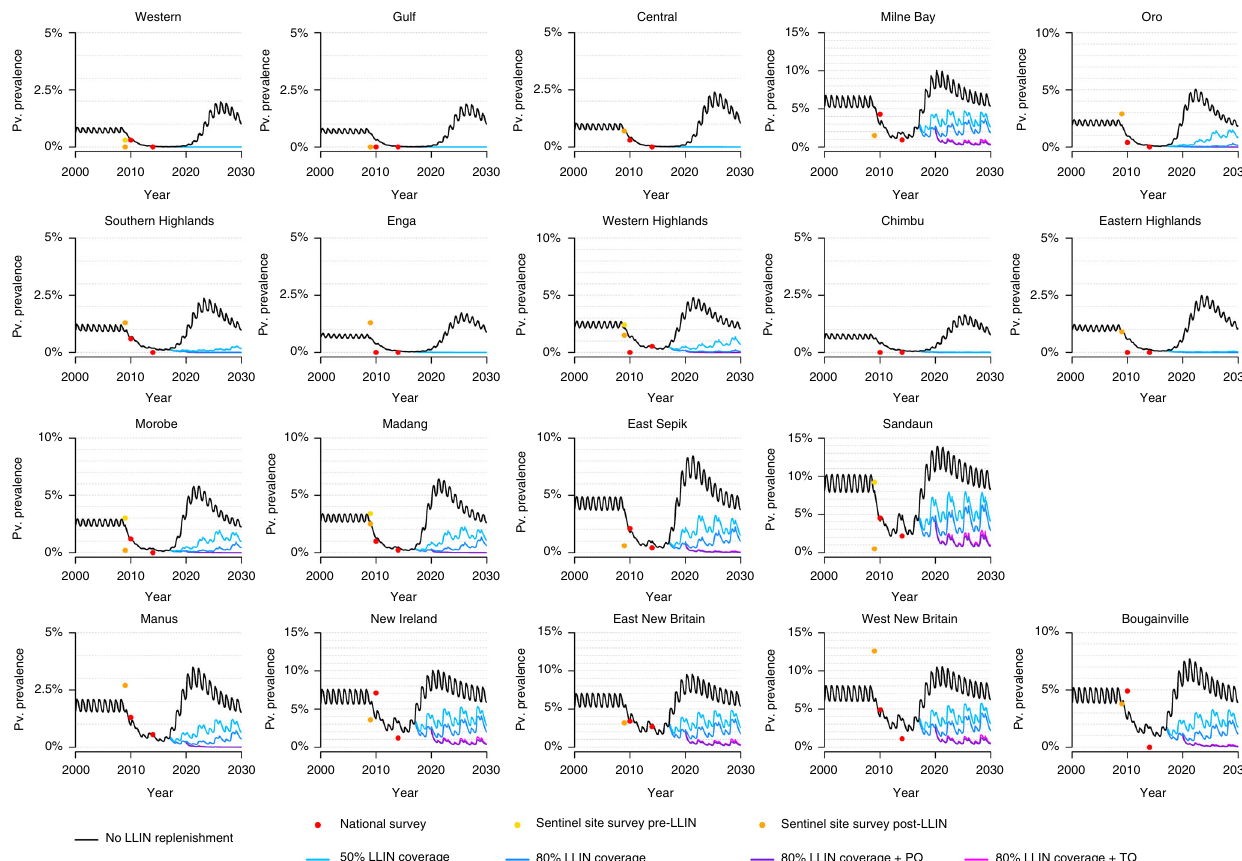
Fig. 3 Predicted Pv PR LM in Papua New Guinean provinces using individual-based model. Model predictions are based on the median of 100 stochastic simulations. Data are from household prevalence surveys in randomly selected villages 14 , and surveys from a number of sentinel villages either before or after LLIN distribution 13 . The black curves denote the model-predicted scenario if LLINs are not replaced. In the LLIN campaigns, nets are assumed to be distributed every 3 years, with 50% of nets still in use after 19.5 months. Primaquine (PQ) or tafenoquine (TQ) with accompanying G6PD screening are assumed to be include in fi rst-line treatment regimens from 2020, with 50% of individuals experiencing a clinical episode of P. vivax being tested and